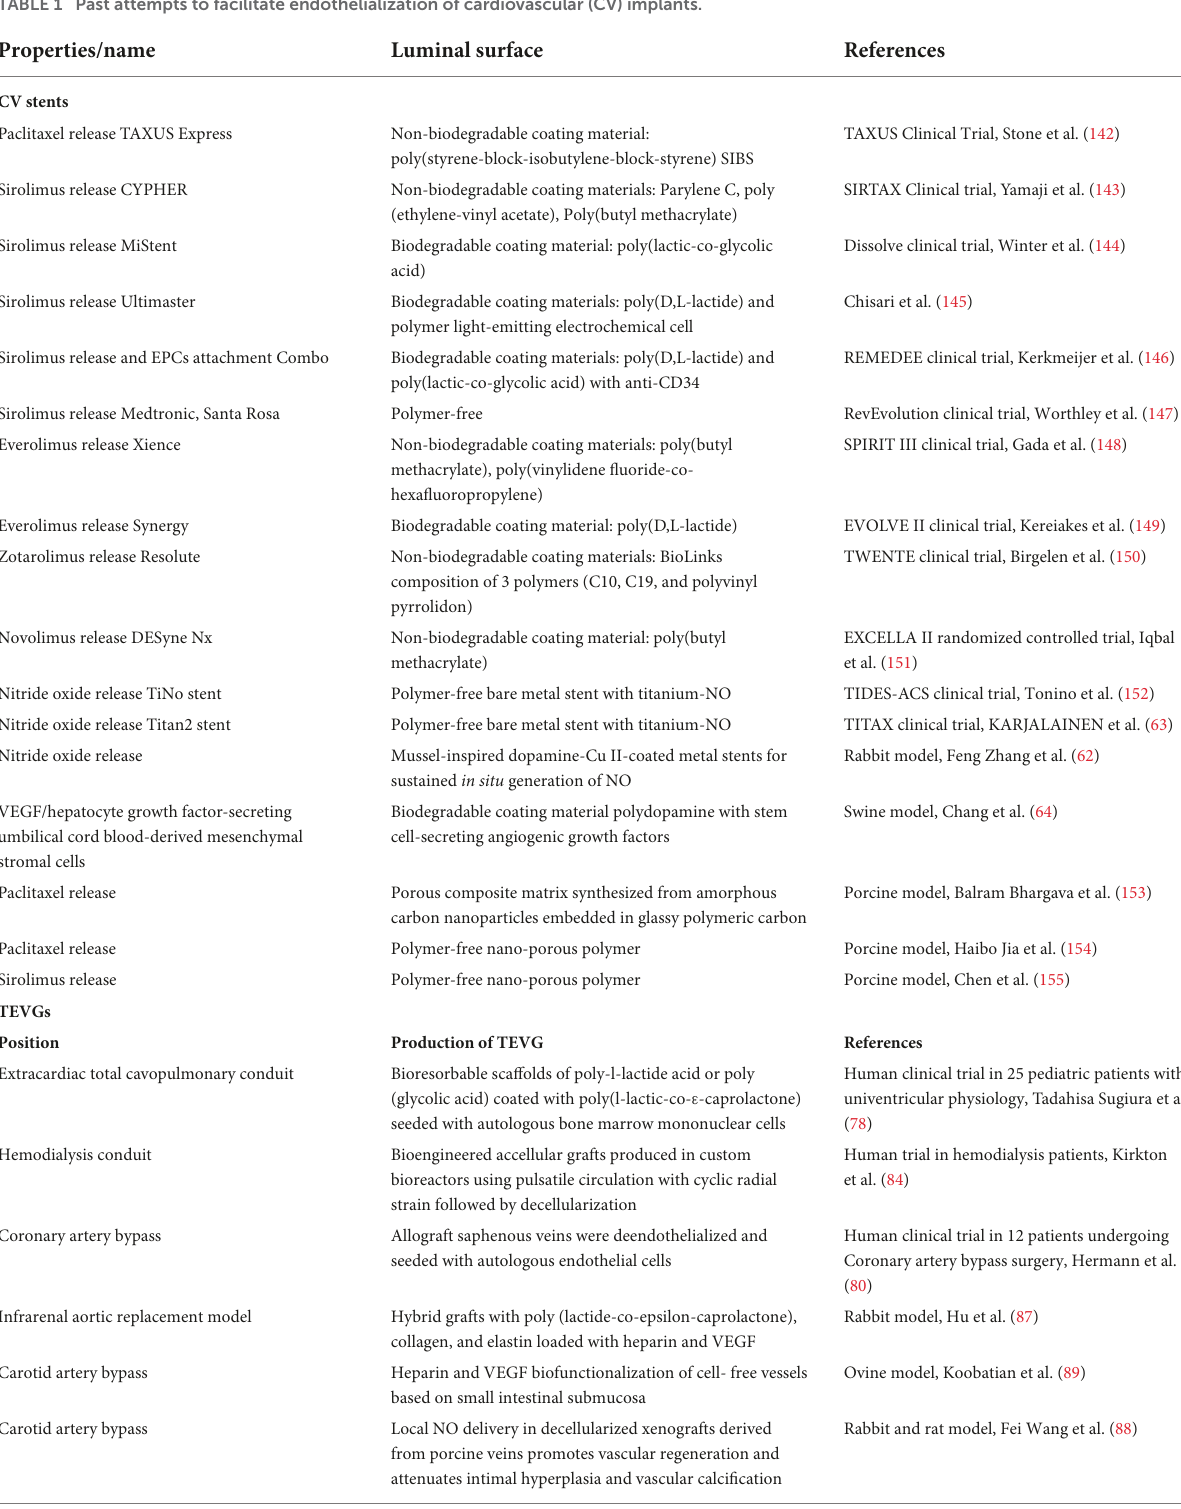
TABLE 1 Past attempts to facilitate endothelialization of cardiovascular (CV)